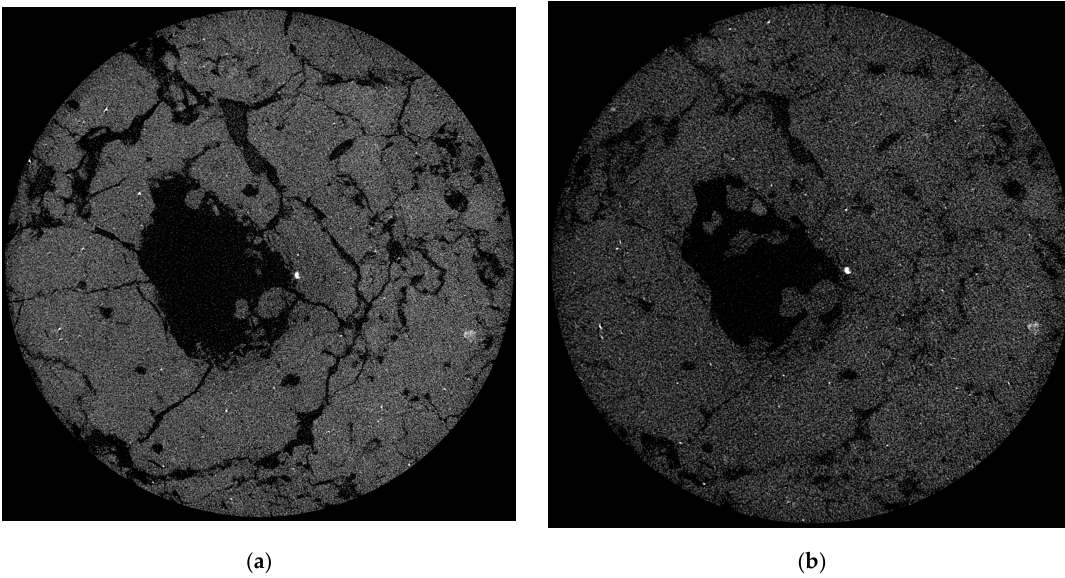
Figure 2. Two-dimensional slices of tomographic images of one of the studied samples ( a ) in a dry condition and ( b ) moisture-saturated condition. In the two images, the cross sections corresponding to the same height of the specimen are shown.